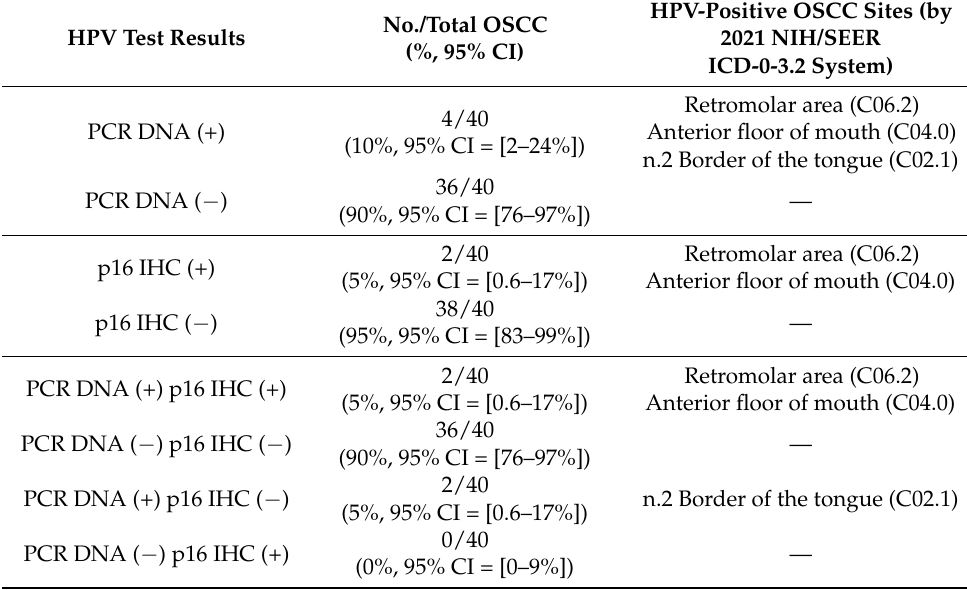
Table 3. Detailed PCR HPV-DNA and p16 IHC results in 40